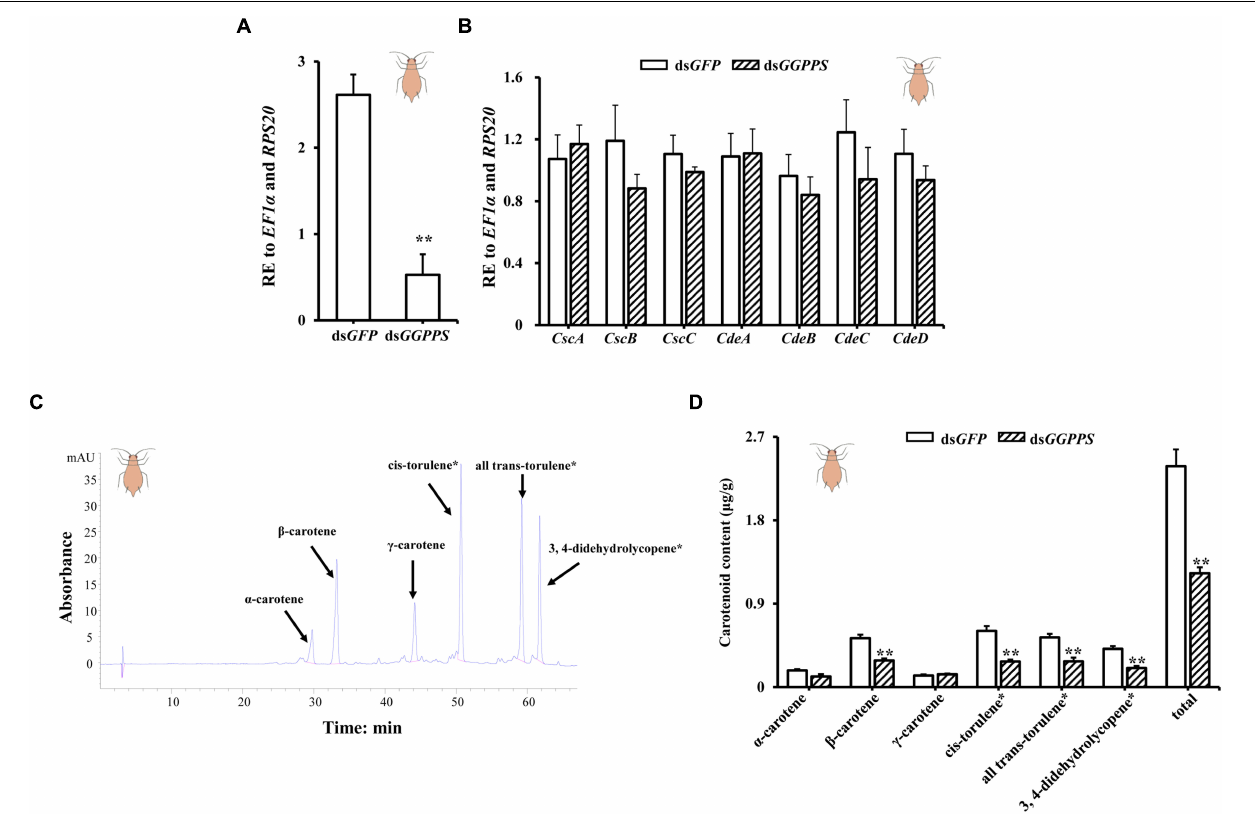
FIGURE 4 | Expression patterns of GGPPS , carotenoid biosynthesis-related genes, and carotenoids content upon silencing of GGPPS in the red morph of Acyrthosiphon pisum . (A) RNAi efficiency of GGPPS . (B) Expression patterns of carotenoid biosynthesis-related genes after RNAi of GGPPS . (C) The prominent peak retention time of red morph by HPLC. Black arrows represent different carotenoids. (D) Carotenoid content of the red morph after silencing of GGPPS . Significant differences between ds GFP and ds GGPPS are indicated by asterisks ( ∗∗ P <